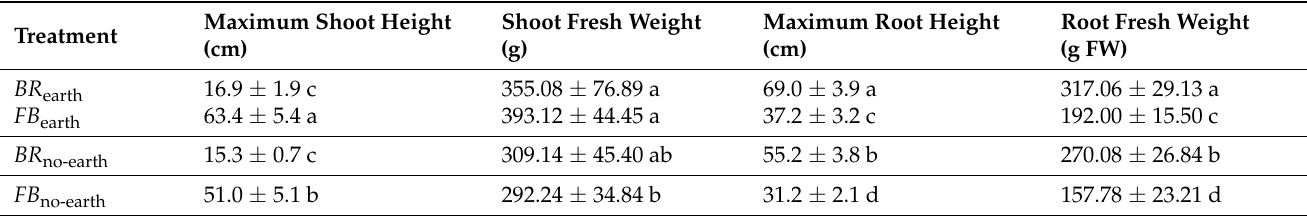
Table 2. Maximum shoot height, shoot fresh weight, maximum root length, and root fresh weight in plants under different treatments, consisting of broccoli with earthworms ( BR earth ), broccoli without earthworms ( BR no-earth ), faba bean with earthworms ( FB earth ), and faba bean without earthworms ( FB no-earth ). Each value represents the mean ( ± SD) from four measurements ( n = 4). Means fol- lowed by different letters within columns are significantly different at 5% probability level (Tukey’s HSD